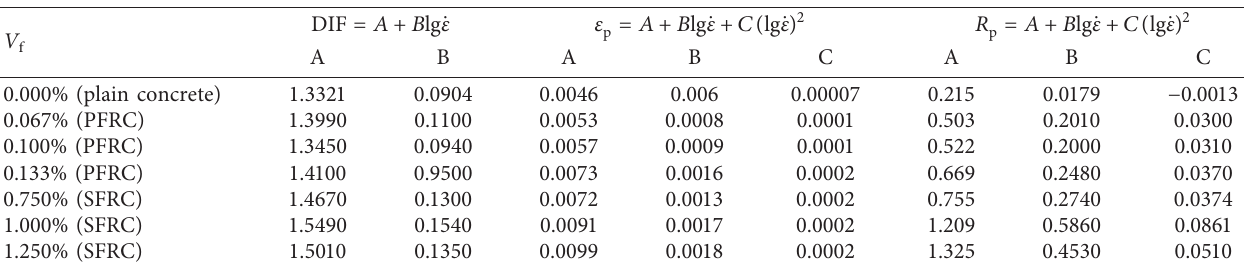
Figure 8: (a) Data fitting of PFRC between DIF and lg _ ε . (b) Data fitting of SFRC between DIF and lg _ ε . Table 5: Fitted DIF